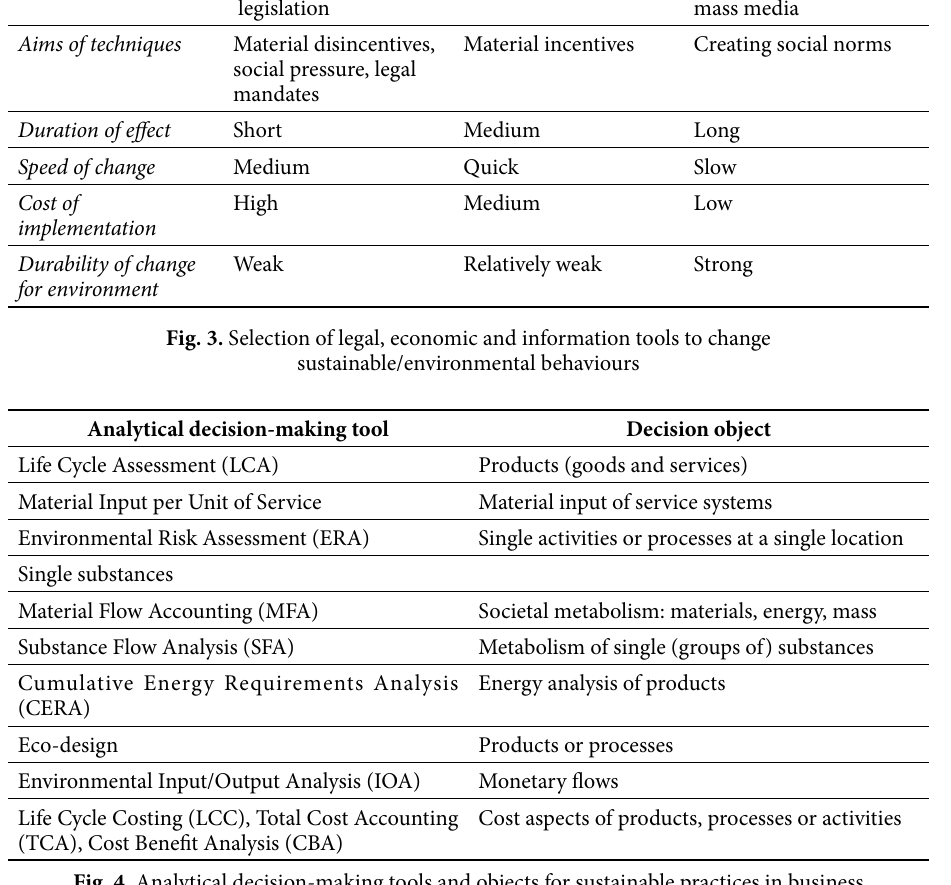
Fig. 4. Analytical decision-making tools and objects for sustainable practices in business